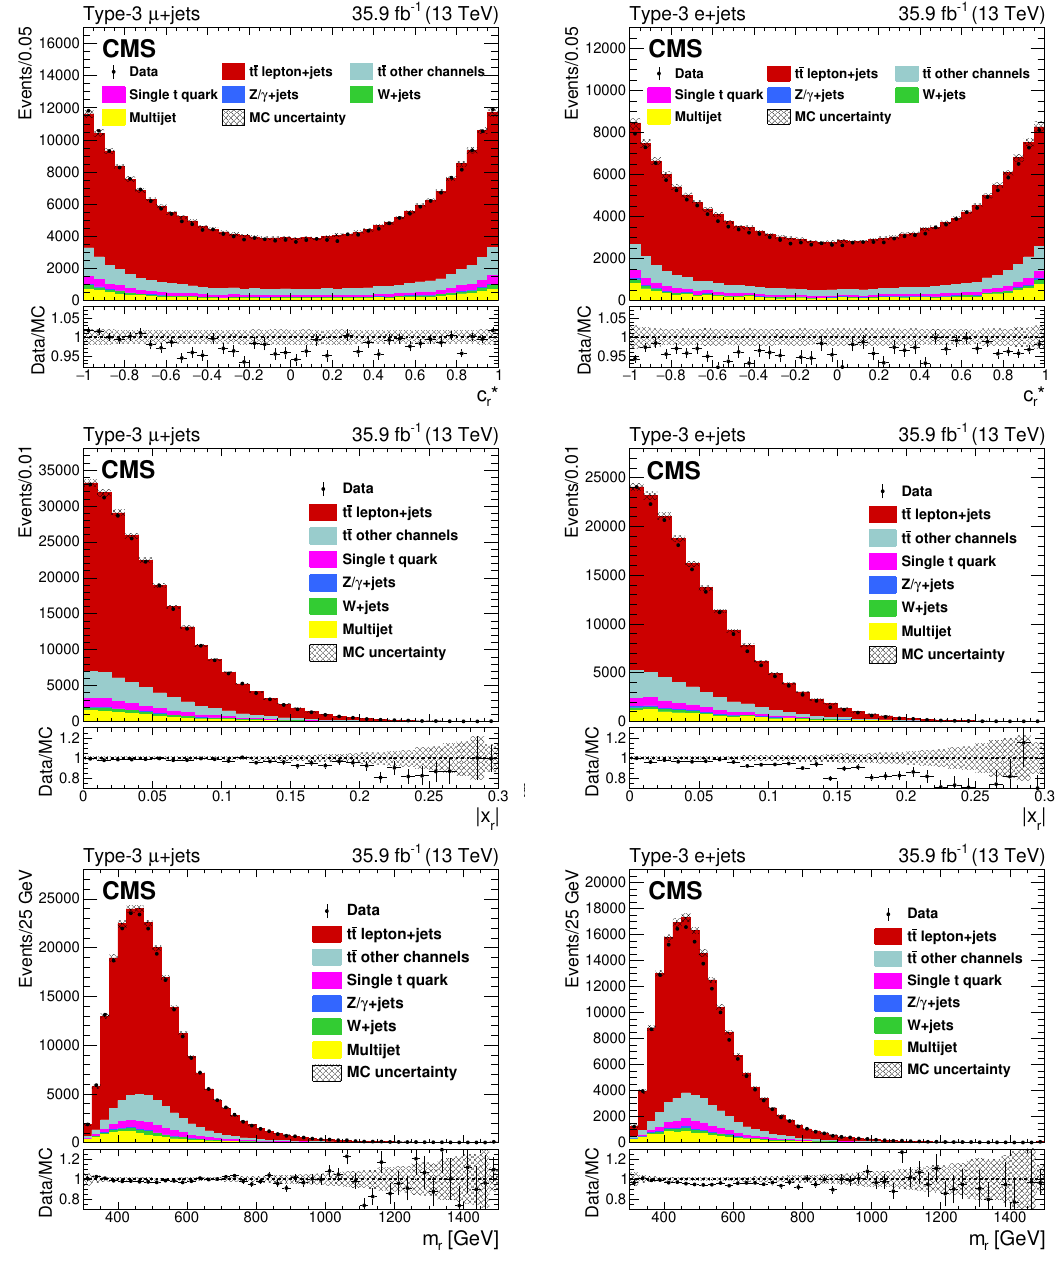
Figure 6 . Data/MC comparison of reconstructed c (cid:3) events passing type-3 m +jets (left column) and e+jets (right column) selection criteria. The MC signal and background show their nominal predictions, with the MC uncertainty pictured in the hatched bands representing statistical uncertainties. The contribution from multijet background is estimated from data, as discussed in section 6. The lower panels of each (cid:12)gure show the ratio of the observed data to MC expectation in each bin, and the last bins of the j x